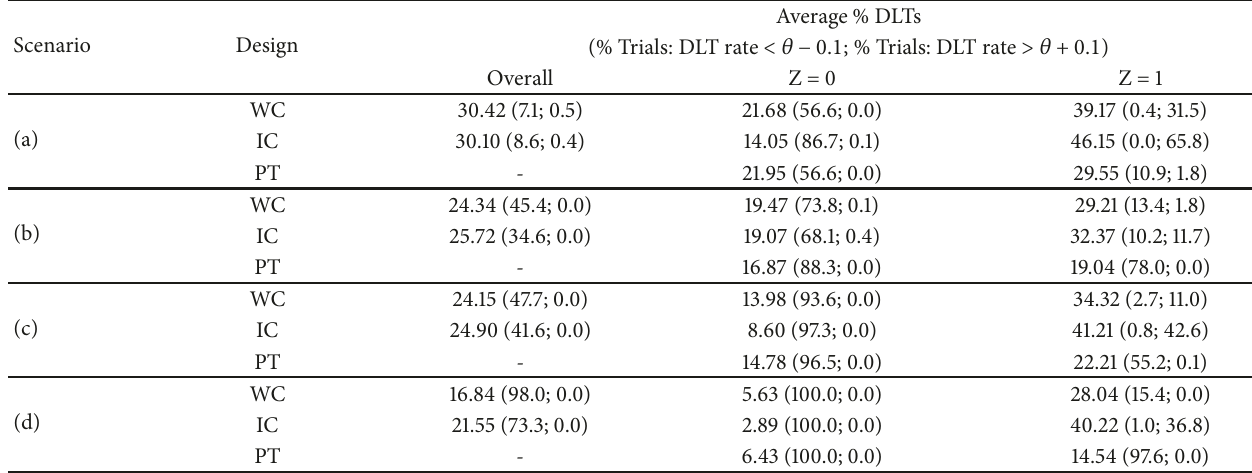
Table 1: Operating characteristicssummarizing trial safety for designs using a covariate (WC), ignoring the covariate (IC), and parallel trials (PT) considering continuous dose combinations, 𝜃 = 0.33